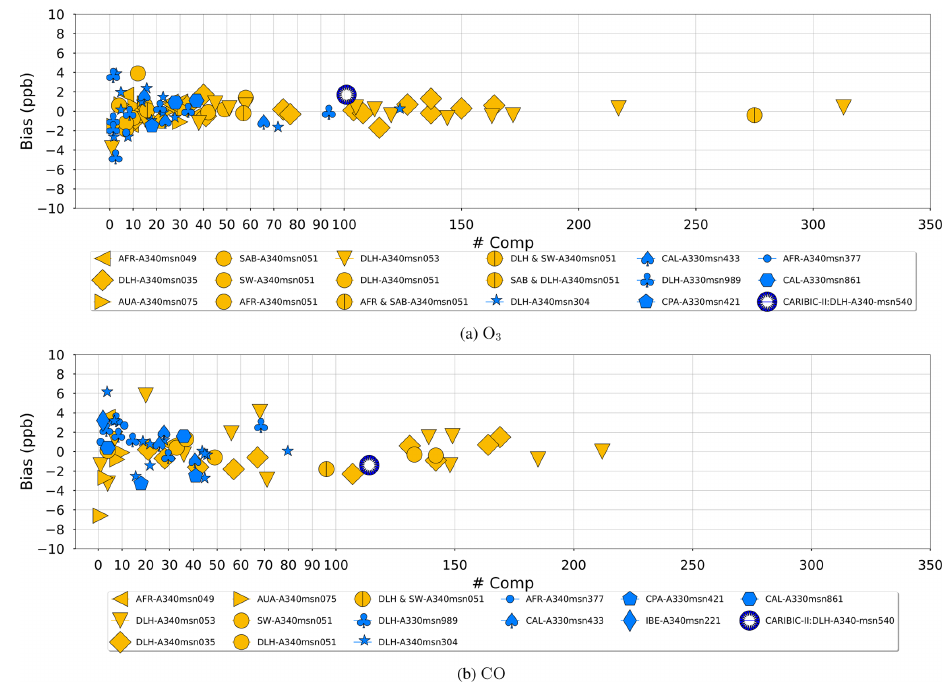
Figure 11. Dependency of the O 3 (a) and CO (b) instrument measurement mean bias for each FP with the number of flight intercomparison profiles. Different symbols are used for each distinct aircraft (same as Fig. 10); the yellow color is for the MOZAIC program and the blue color is for IAGOS and